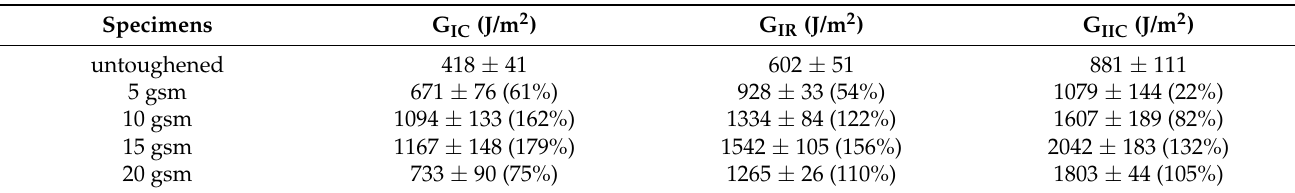
Table 1. The results of DCB and ENF tests for the untoughened and interleaved laminates. The values in brackets represent the percentage increase of G I and G IIC values over the untoughened specimen.